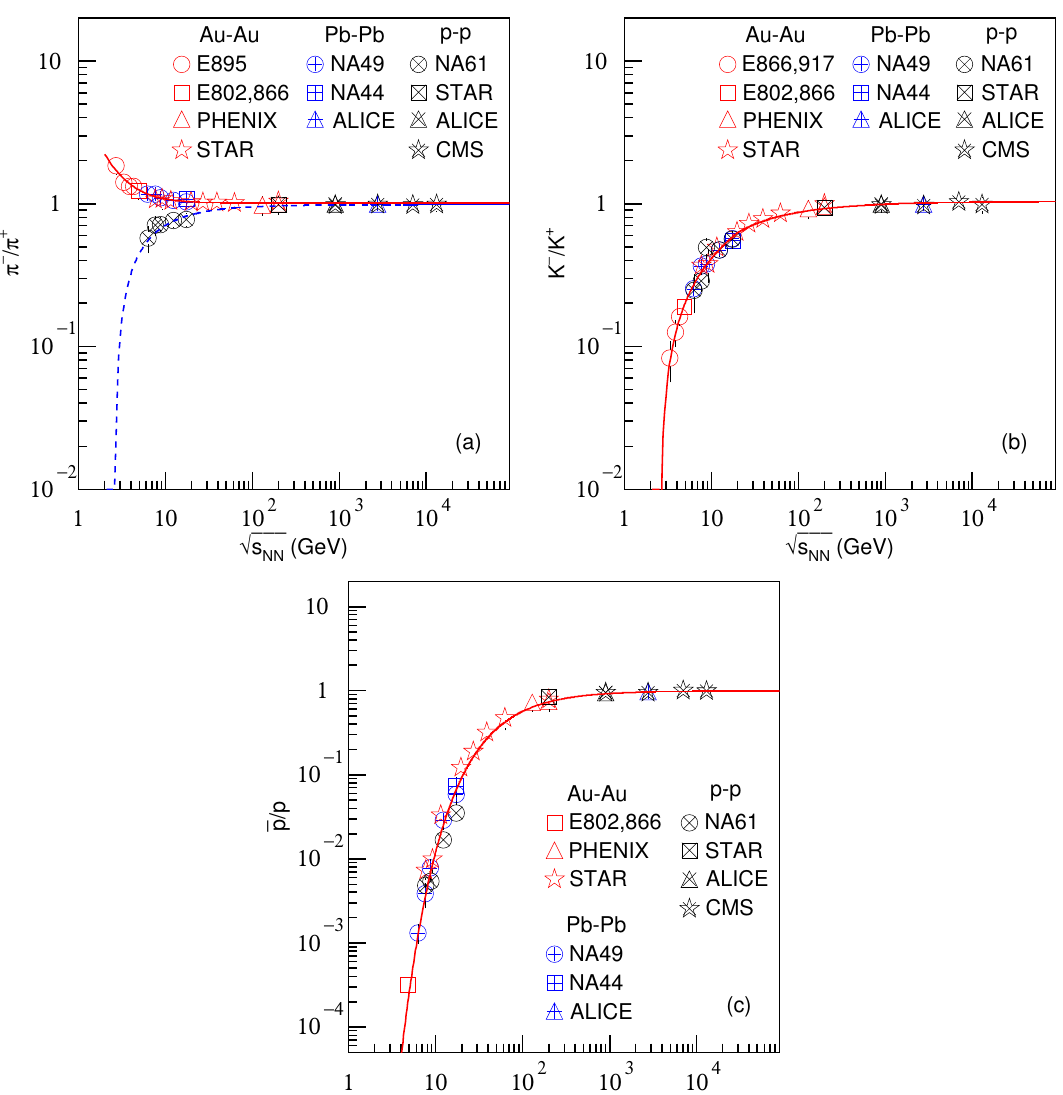
Figure 1. Yield ratios of antiparticles to particles produced in mid-rapidity interval (in most cases) in central Au–Au (Pb–Pb) and INEL or NSD pp collisions at high energies: ( a ) π − / π + ; ( b ) K − / K + ; and ( c ) ¯ p / p . The symbols denote the data measured in different collisions by different collaborations marked in the panels, where the idiographic references are indexed in the text. In particular, the NA61/SHINE data appear in the forward rapidity region (in the center-of-mass system), although the experiment can provide results with 4 π geometry. The solid and dashed curves in ( a ) are the results √ s NN dependent π − / π + in central Au–Au (Pb–Pb) and INEL or NSD pp collisions, fitted by us for the √ s NN dependent K − / K + and respectively. The solid curves in ( b , c ) are the results fitted by us for the ¯ p / p respectively, for the combining central Au–Au (Pb–Pb) and INEL or NSD pp